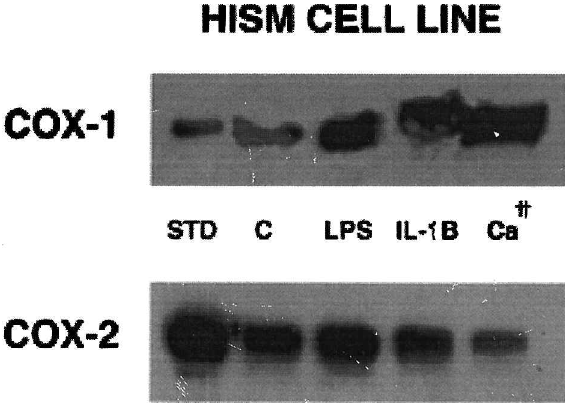
FIG. 1. Western immunoblotting of COX-1 protein and COX-2 protein in unstimulated HISM cells and in cells stimulated for 8h with LPS (100 m g/ml) and IL-1 b (100 units/ml). Calcium ionophore (5 m M) was also evaluated. Unstimulated cells demonstrated constitutive COX-1 and COX-2 protein was increased by LPS or IL-1 b . Unstimulated cells demonstrated constitutive COX-2 protein. Both LPS and IL-1 b induced COX- 2 protein